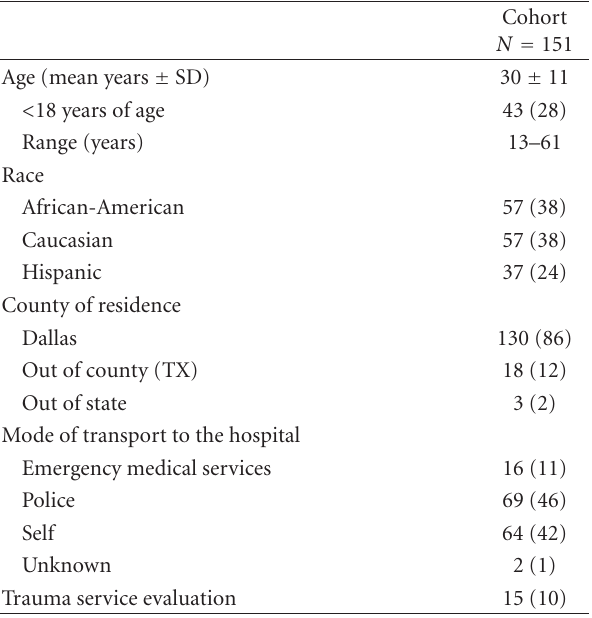
Table 4: Characteristics of the women receiving HIV nPEP medications.